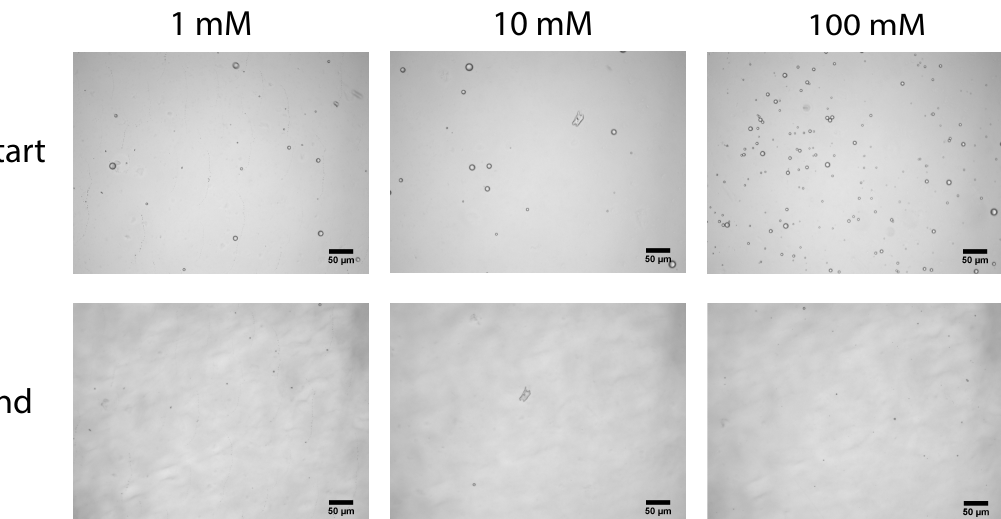
Figure 5. Images of the cellulose coated glass with attached droplets in the flow cell at 1, 10 and 100 mM NaCl and 463 mg/L SDS. The Start images were taken after flushing of the flow cell at the lowest possible speed, the End images were taken after the maximum shear force was